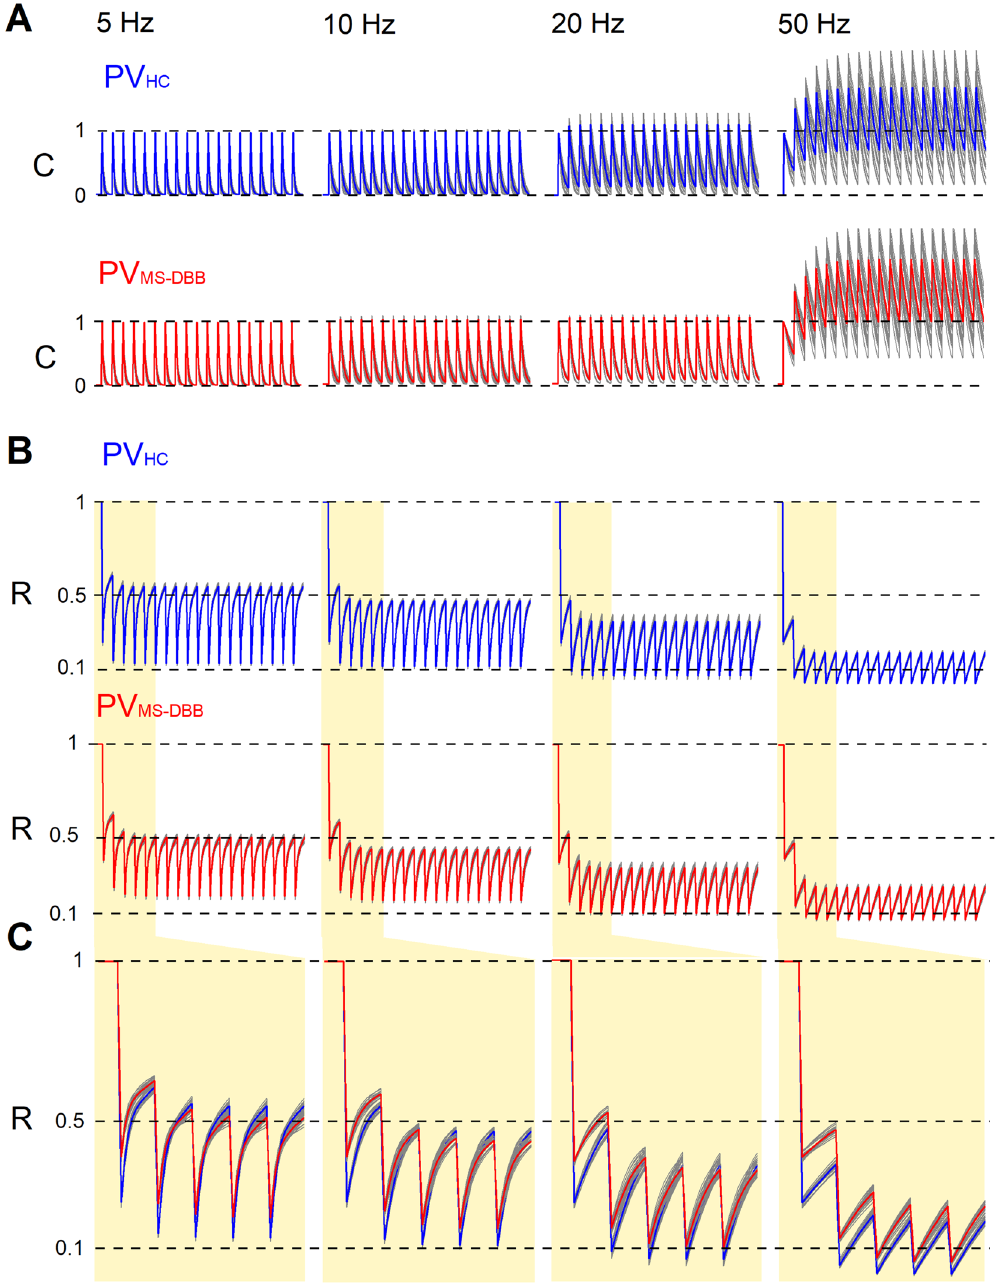
Figure 8. PV MS-DBB and PV HC synapse models reproduce differences in STD dynamics. ( A ) Plots of the change in intracellular ( (cid:31) [Ca] dynamics, C; values 0–1) for PV HC (blue) and ( B ) PV MS-DBB (red) synapse models. ( C ) is similar across 5–50 Hz between PV HC and PV MS-DBB synapses. ( B ) Fraction of vesicles available for release (R; values 1–0) across 5–50 Hz frequencies for PV HC (blue) and PV MS-DBB (red) synapse models. ( C ) The first 5 stimuli in the pulse train from B (yellow region) are shown at expanded scale. At 20 and 50 Hz, activity-dependent accumulation of calcium promotes greater resistance to STD in the PV MS-DBB synapse model by accelerating calcium-dependent recovery. Grey traces are MCMC simulations; colored traces are the average. Parameters from Table 1 were used for the simulations. See also Figure S6 for comparisons of calcium- dependent recovery rates across calcium